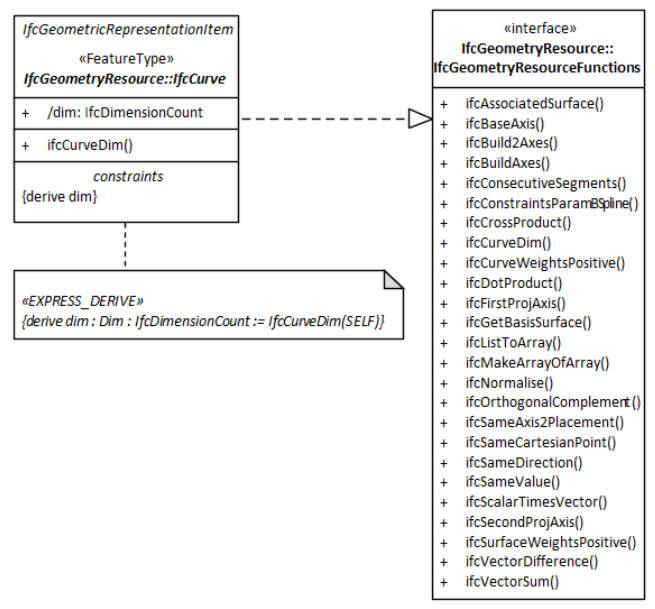
Figure 10. UML class diagram showing realization of the operation IfcCurveDim in the class IfcCurve.